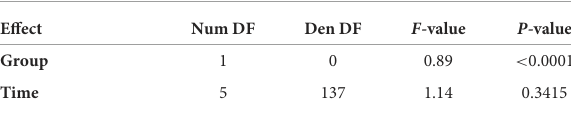
TABLE 5 Mixed-effect model for systemic valve